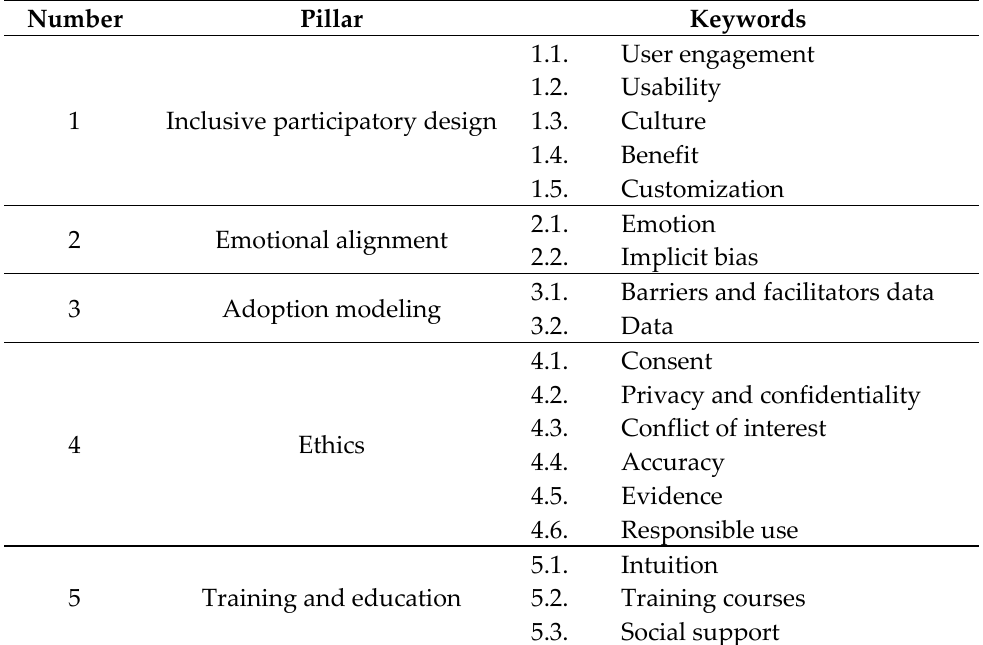
Table 3. Ethical adoption in the context of